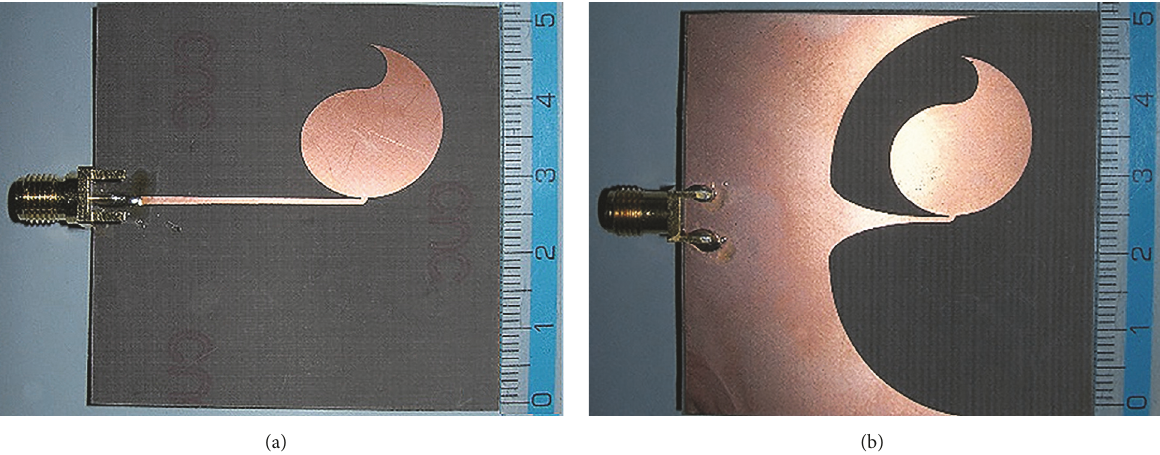
Figure 2: Prototype of the drop-shaped antipodal dipole antenna equipped with a metal reflector: (a) top view, (b) bottom view.